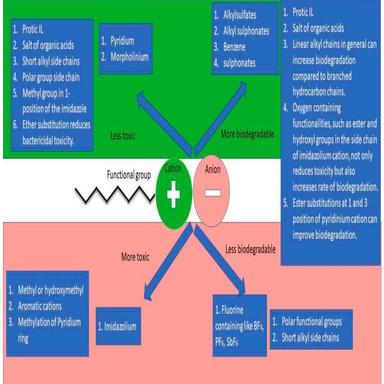
Suggested preparation of IL.